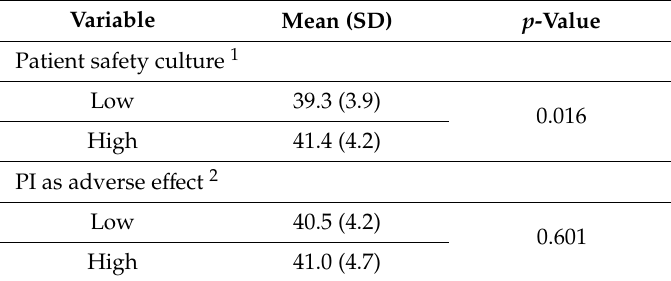
Table 6. Known-group test of the APuP questionnaire (Spanish version).